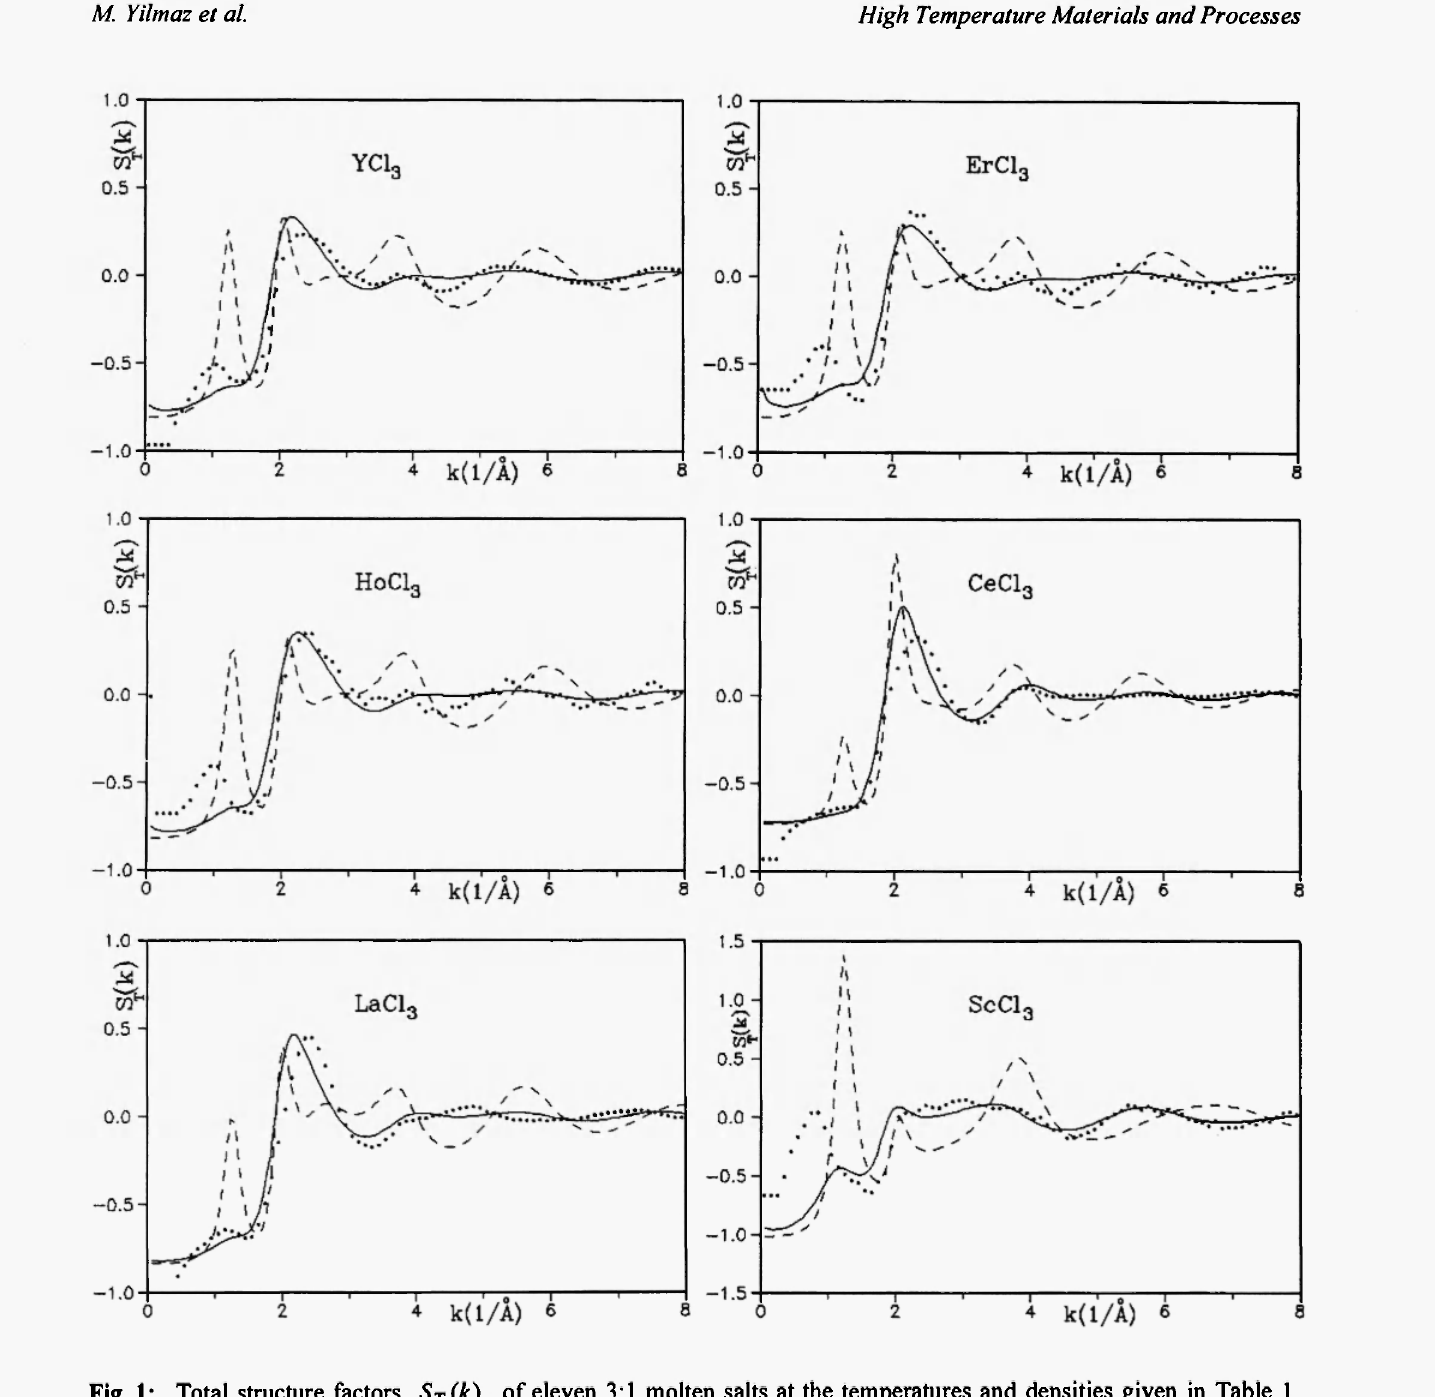
Fig. 1: Total structure factors, S T (k) , of eleven 3:1 molten salts at the temperatures and densities given in Table 1. Dotted lines: Experimental neutron diffraction data. Broken lines: HNC results using the TAPT potentials. Solid lines: HNC results using the VR